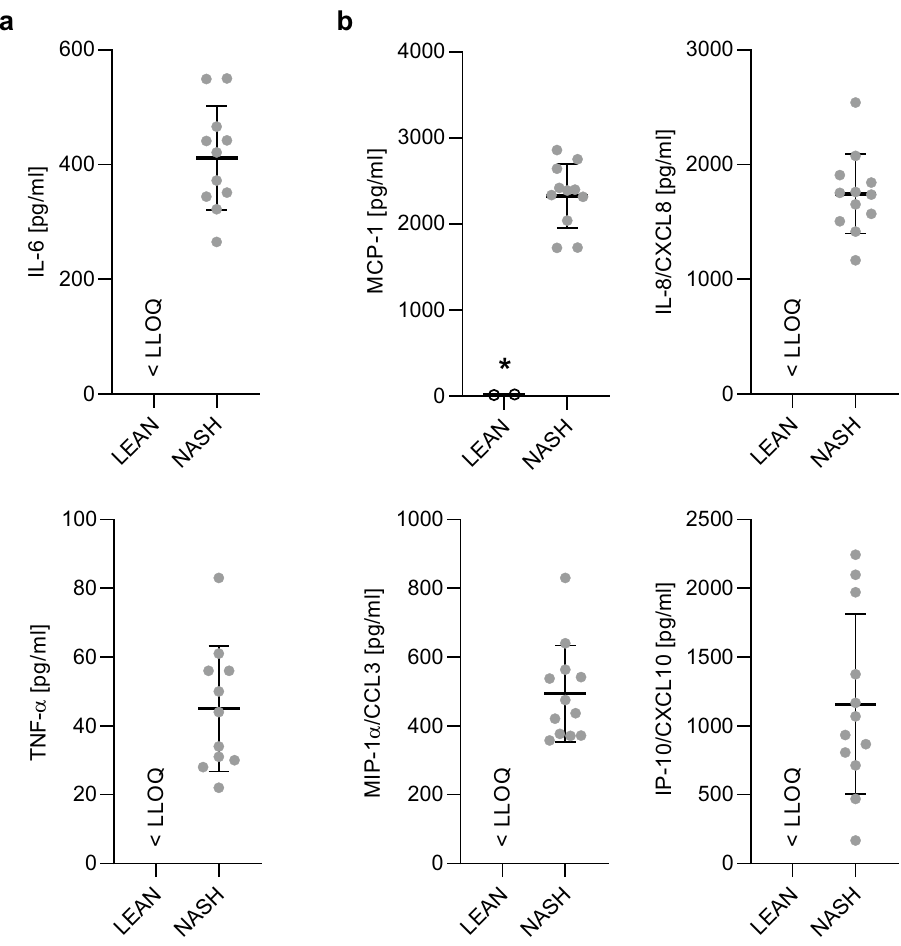
Figure 3. Induction of inflammation in NASH-treated hLiMTs. FFA and LPS-mediated induction of NASH leads to a pro-inflammatory phenotype compared to LEAN control, with the detection of ( a ) increased secretion of pro-inflammatory cytokines: IL-6 and TNF-α and ( b ) chemokines: MCP-1 (*p < 0.05), MIP-1α (CCL3), IL-8 (CXCL8) and IP-10 (CXCL10). Secreted cytokines/chemokines by various liver cells: KCs: IL-6, MIP-1α (CCL3), TNF-α, HSCs: IP-10 (CXCL10), MCP-1, IL-8, PHHS: IL-8, MCP-1 (3 experiments, n = 12). Lower level of quantification (LLOQ) was applied where quantification was below the lowest assay